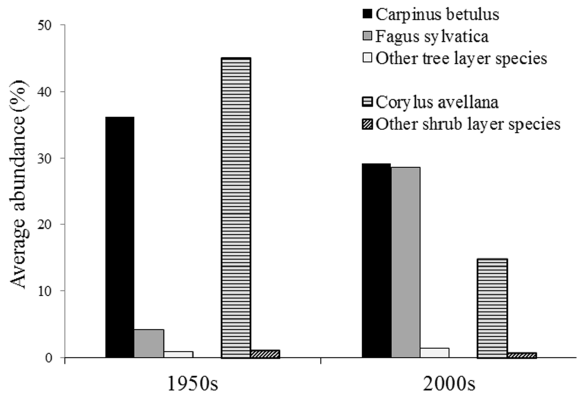
Figure 1. Changes in abundance of the tree and shrub layer species between sampling